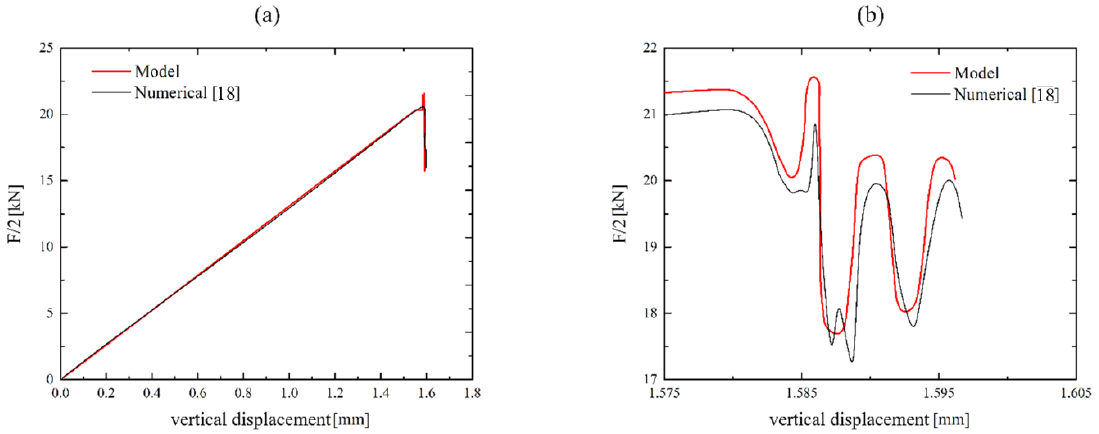
Loading displacement curve: comparison with numerical data published in [18]. ( a ) The loading displacement curve; ( b ) A detail of the resistance curve at the point in which the crack onset is activated.